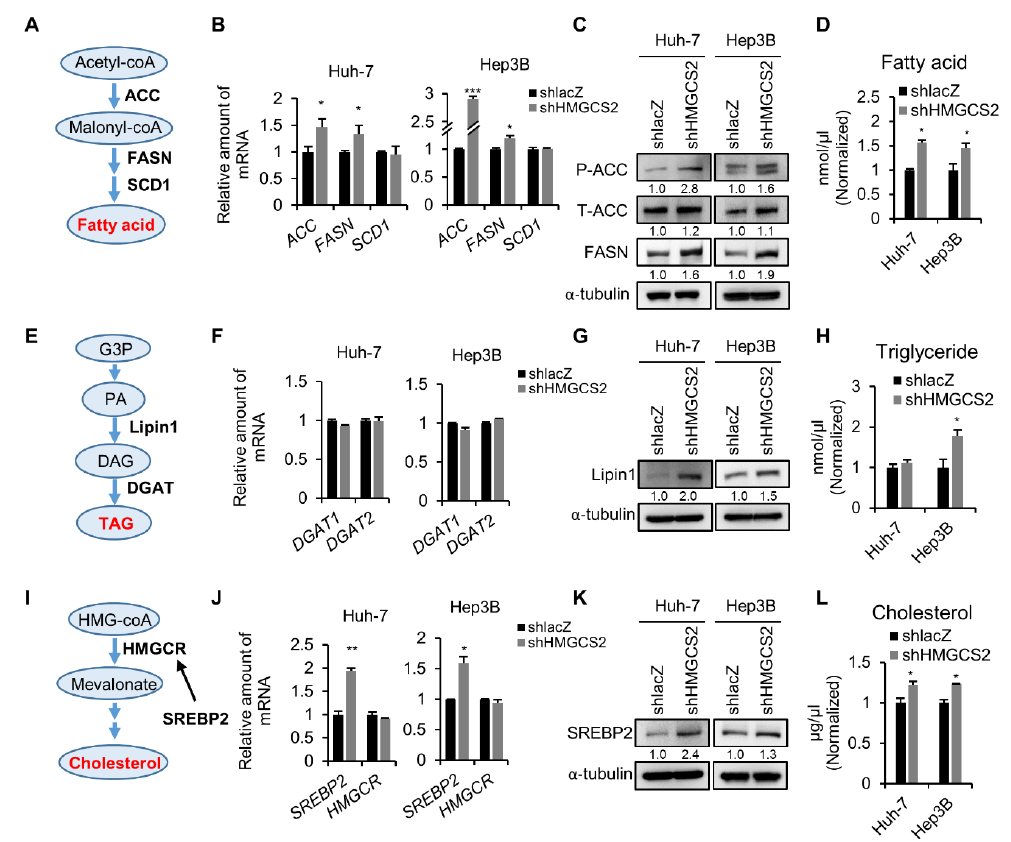
Figure 3. HMGCS2 downregulation affects fatty acid, triglyceride, and cholesterol synthesis in both Huh-7 and Hep3B cells. ( A ) Diagram of fatty acid synthesis. ( B ) qPCR analyses of ACC, FASN, and SCD1 gene expression. ( C ) Representative western blotting images of T/p-ACC, and FASN expression. ( D ) Intracellular fatty acids were measured using a colorimetric fatty acid quantification kit. ( E ) Diagram of triglyceride synthesis. ( F ) qPCR analyses of DGAT1 and DGAT2 gene expression. ( G ) Representative western blotting images of Lipin1 expression. ( H ) Intracellular triglyceride was confirmed by using a colorimetric triglyceride quantification kit. ( I ) Diagram of cholesterol synthesis. ( J ) qPCR analyses of SREBP2 and HMGCR gene expression. ( K ) Representative western blotting images of SREBP2 expression. ( L ) Intracellular cholesterol was measured by using a colorimetric cholesterol quantification kit. The quantification of the western blot images was presented by using